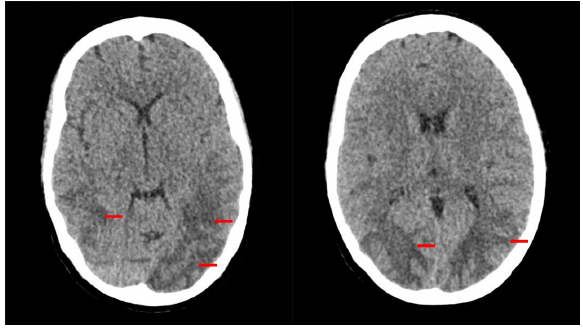
Figure . 2. Brain CT-scan showing areas of hypo attenuation involving predominantly the sub-cortical white matter in both occipital lobes right greater than left (Red arrows).